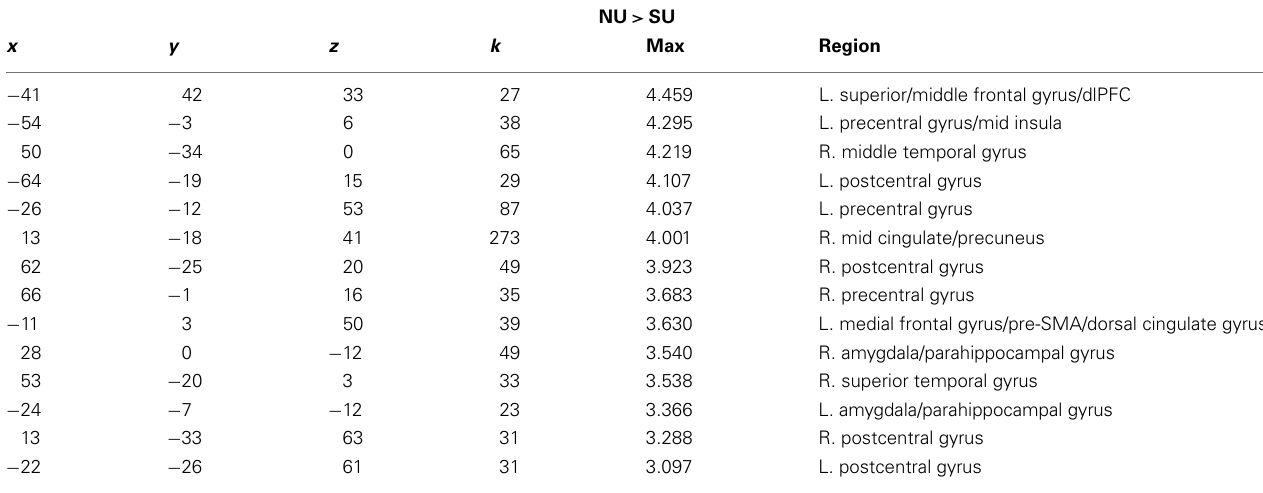
Table 6 | x , y , z coordinates, max activation, and cluster size for the contrast of non-using > substance-using mothers for high-distress infant cries.